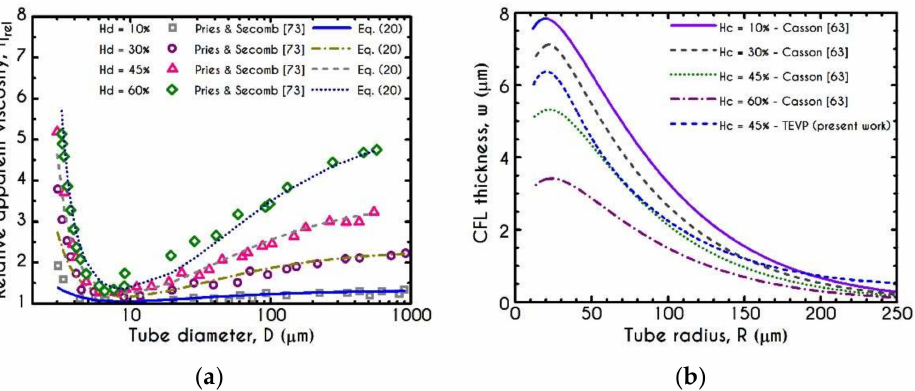
Figure A1. ( a ) The predictions of our proposed expression (Equation (20)) for relative apparent viscosity against experimental data reported by Pries and Secomb [73]. ( b ) Cell-free layer variation with respect to the tube radius and different values of core hematocrit based on Equation (20) for two different constitutive models applied in the core-annular flow problem described in Section 2.